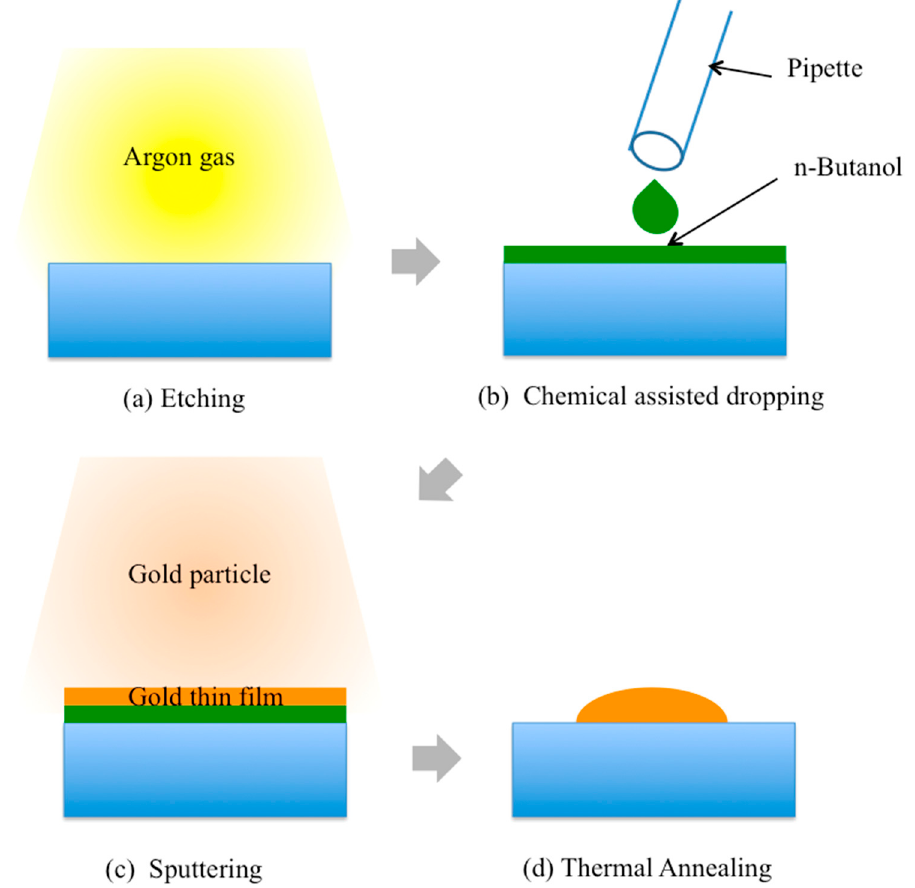
Figure 3. Schematic illustration of the substrate-assisted chemical etching based on the thermal annealing process. ( a ) Argon spatter etching, ( b ) substrate assisted by n-Butanol, ( c ) gold thin film sputter coating onto a substrate, ( d ) the gold nanoislands agglomerated via thermal annealing